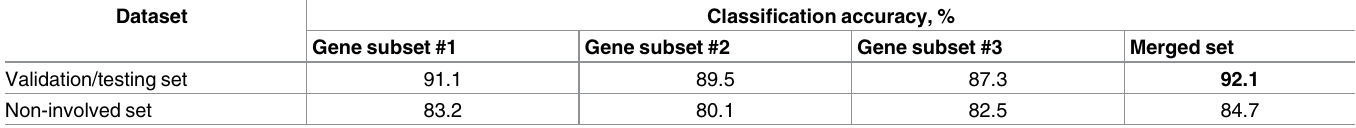
Table 5. Accuracypercentage of the SVM classifier at the final stage of gene selection by the GBPSO-SVM algorithm in 10-fold cross-validation and the accuracyof the new dataset in terms of the model.